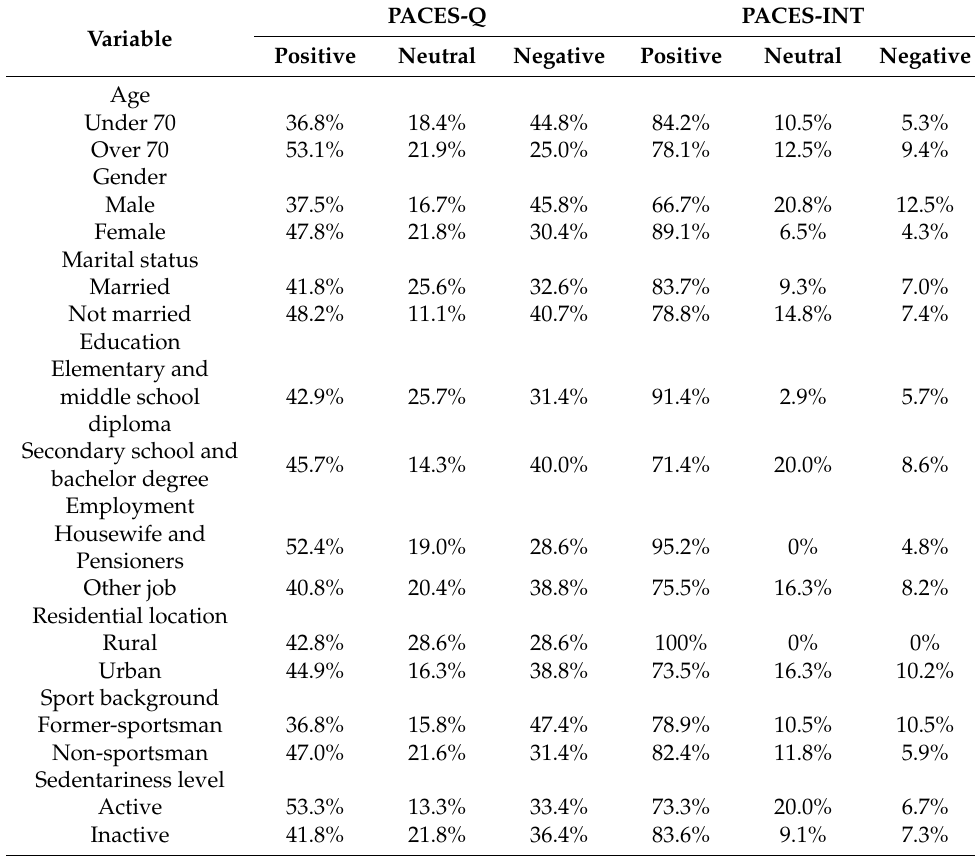
Table 3. Sample subgroups’ enjoyment (%).